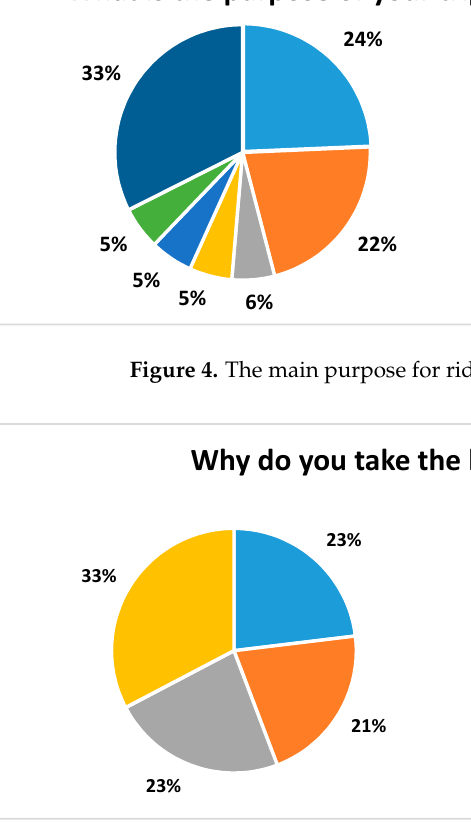
Figure 5. Reasons for taking the bus.